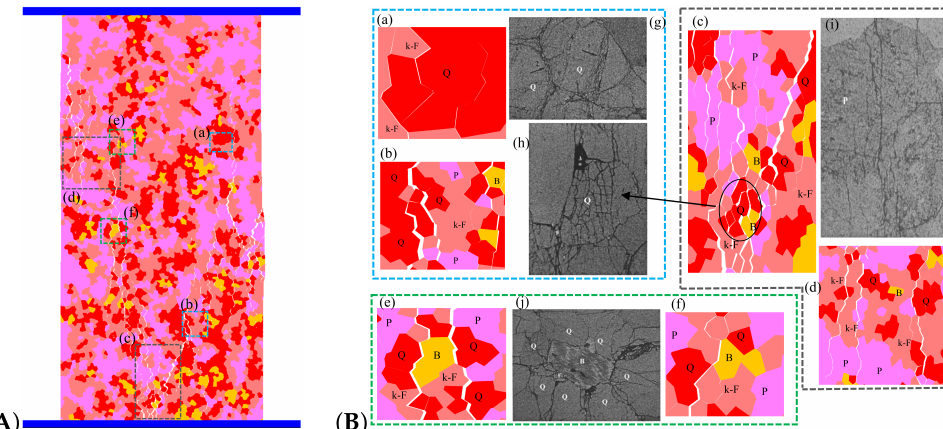
Figure 1. 1. Figure 18. The fracture characteristics of micro-cracks between different rock components during uniaxial compression failure. ( A ) Macroscopic view of a rock with fabric heterogeneity during compression fracture; ( B ) Enlarged view of local cracking: subfigures ( a – f ), represented in numerical model. subfigures ( g – j ), represented observed in the experiment [60]. NOTE: The blue, black, and green colored dotted boxes represent the comparison of numerical simulation and experimental observation of quartz, feldspar, and mica when three crystals are